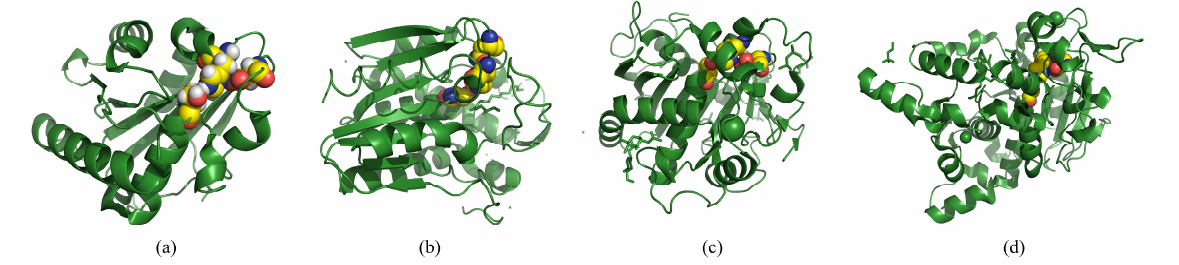
Figure 4. Lipases with different lid structures. ( a ) Crystal structure of lipase A from Bacillus subtilis (PDB entries 5CT5) without lid domain, adapted with permission from Rdf. [73]. Copyright 2015, John Wiley and Sons ( b ) Crystal structure of Monoglyceride lipase from Bacillus sp. H257 (PDB entries 4KE6) with a loop lid domain, adapted with permission from Rdf. [74]. Copyright 2013, Elsevier ( c ) Crystal structure of Lip2 lipase from Yarrowia lipolytica (PDB entries 3O0D) with a helix lid domain, adapted with permission from [75] . Copyright 2010, Elsevier ( d ) Crystal structure of Lipase from Geobacillus thermocatenulatus (PDB entries 2W22) with two helices in its lid domain, adapted with permission from [76] Copyright 2009, Elsevier. The red, yellow, and blue spheres in the diagram are the active catalytic residues of lipase . The copyright detail is shown in supplemen- tary material.